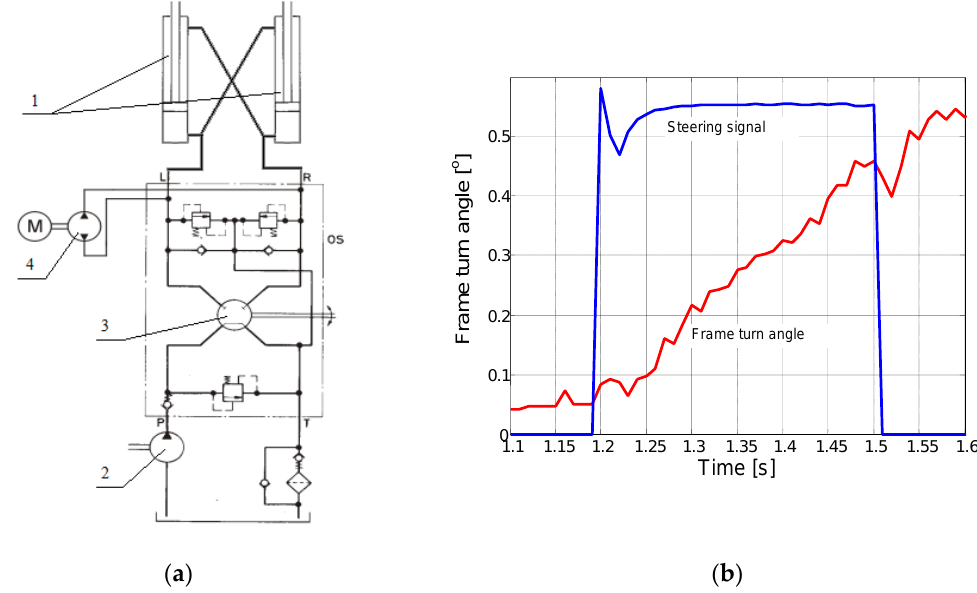
Figure 6. Driver aid system—( a ) diagram of hydraulic steering system with additional driver-aid system: 1—steering hydraulic actuator, 2—main pump, 3—hydraulic steering unit, and 4—additional pump with electric drive; and ( b ) frame turns as results of additional gear pump operation.